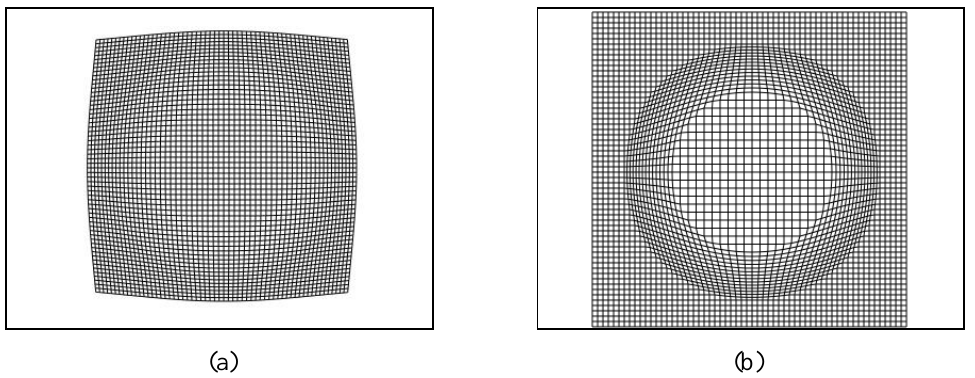
Figure 1. Comparison of the different variable-scale maps: ( a ) the method proposed by Harrie et al. [6]; ( b ) Focus+Glue+Context map. ( b ) Focus + Glue + Context